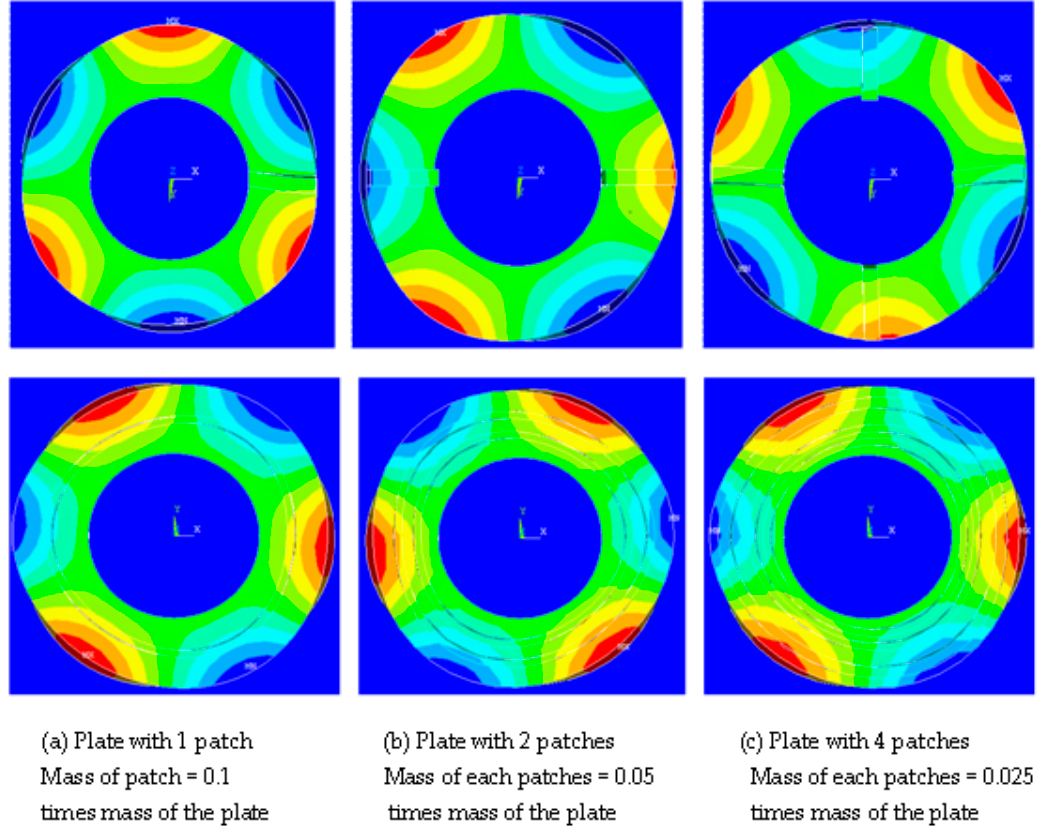
Figure 3. Plate with different arrangements of rectangular and concentric stiffener patches with (0, 3) modes.